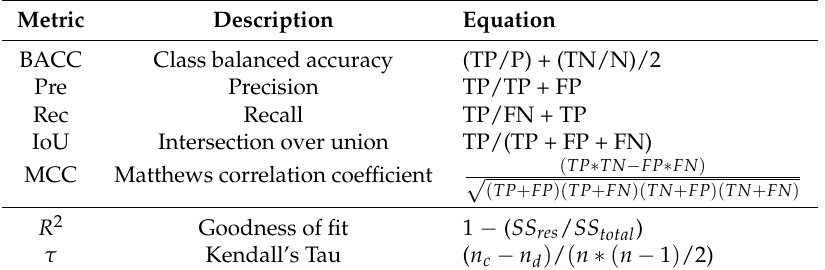
Table 1. Evaluation